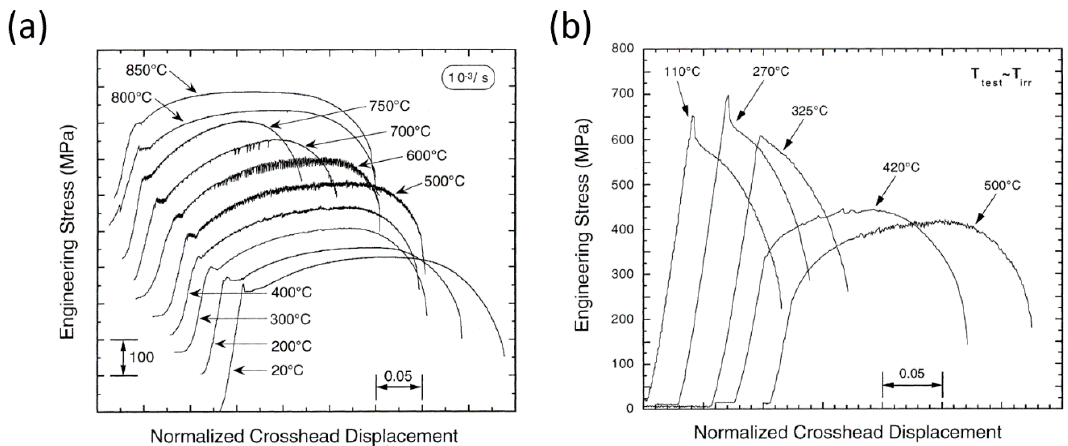
Figure 11. ( a ) Tensile curves for the unirradiated annealed V-4Cr-4Ti at a strain rate of 10 −3 s −1 and ( b ) tensile curves for V-4Cr-4Ti irradiated to 0.5 dpa at 110–420 °C and to 0.1 dpa at 505 °C. The curves were offset on the strain axis for clarity (reproduced from Reference [117] with permission).